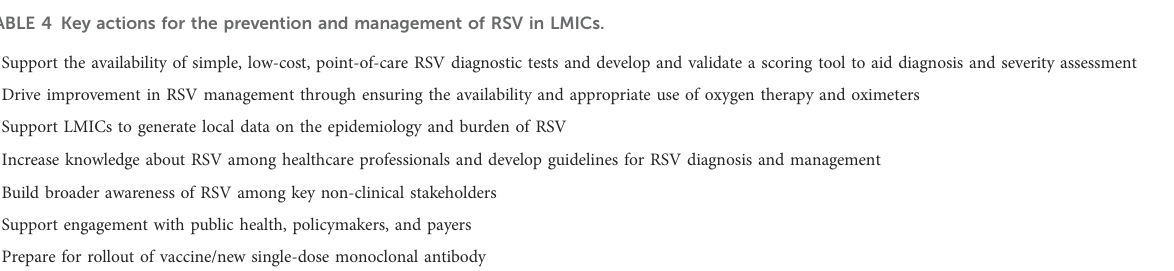
TABLE 4 Key actions for the prevention and management of RSV in